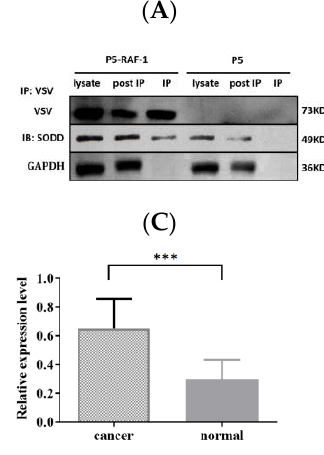
Figure 1. SODD is confirmed as an RAF-1-associated protein and overexpressed in lung cancer tissues. ( A ) VSV-tagged RAF-1 was inserted into the pcDNA5 plasmid (P5) in HEK 293T cells, and VSV beads were used to catch RAF-1-binding proteins. The WB outcome confirms that SODD binds to RAF-1. ( B , C ) SODD expression in lung cancer tissues was analyzed by WB. The expression of GAPDH was detected to ensure the samples’ loading amount. The SODD expression significantly increased in cancer tissues, as compared with adjacent normal tissues. (*** p < 0.001).